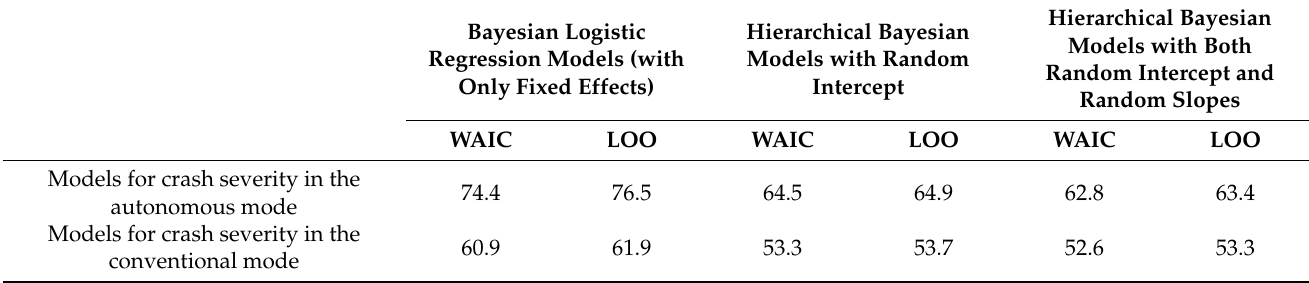
Table 5. WAIC and LOO of hierarchical Bayesian models with different structures. Bayesian Logistic Regression Models (with Only Fixed Effects)